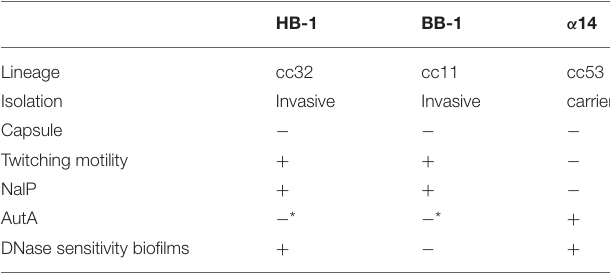
TABLE 1 | Characteristics of strains HB-1, BB-1, and α